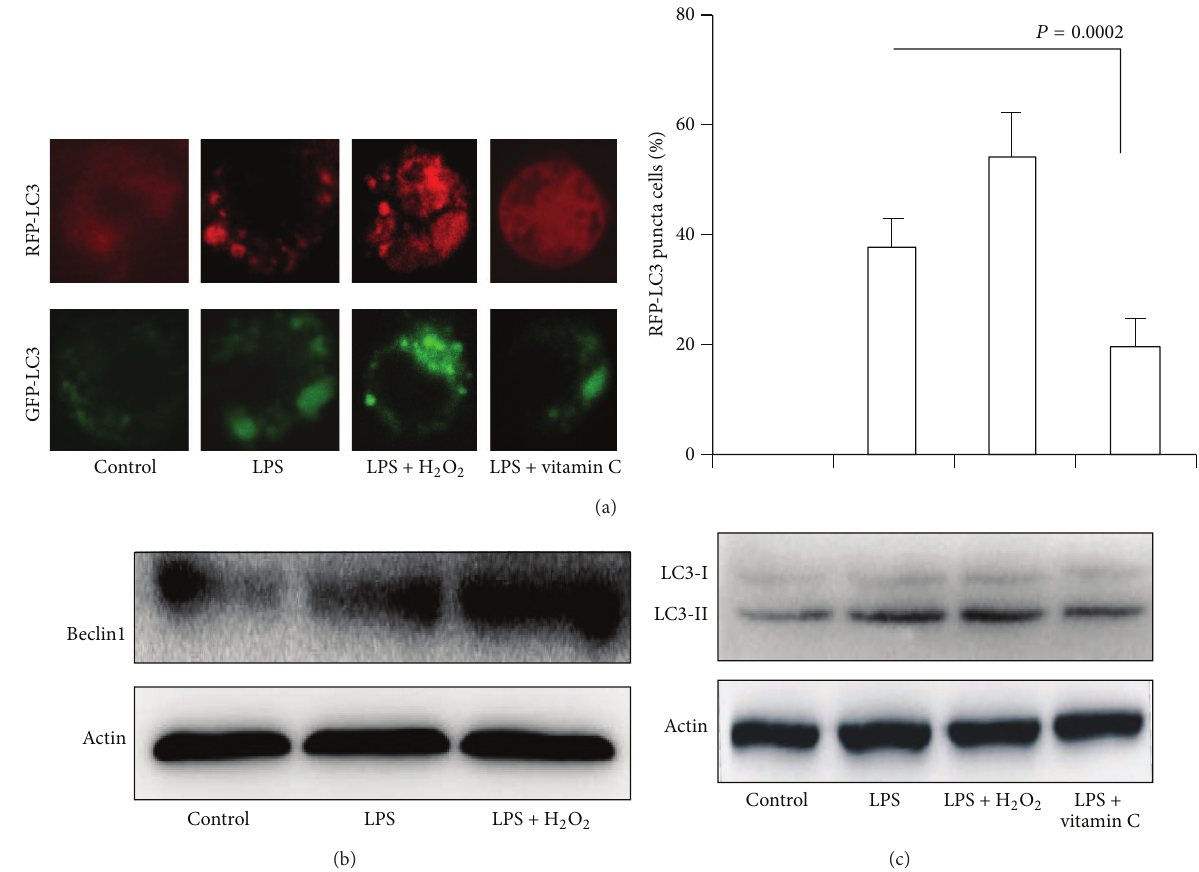
Figure 5: The effect of vitamin C on LPS-induced autophagy in macrophages . (a) MH-S cells were transfected with RFP-LC3 or GFP-LC3 plasmids for 24 hours. MH-S cells were cultured in the presence or absence of vitamin C and treated with LPS for 12 hours. (b) Western blotting of Beclin1; (c) western blotting of LC3. 𝛽 -actin was probed as a loading control in (b) and